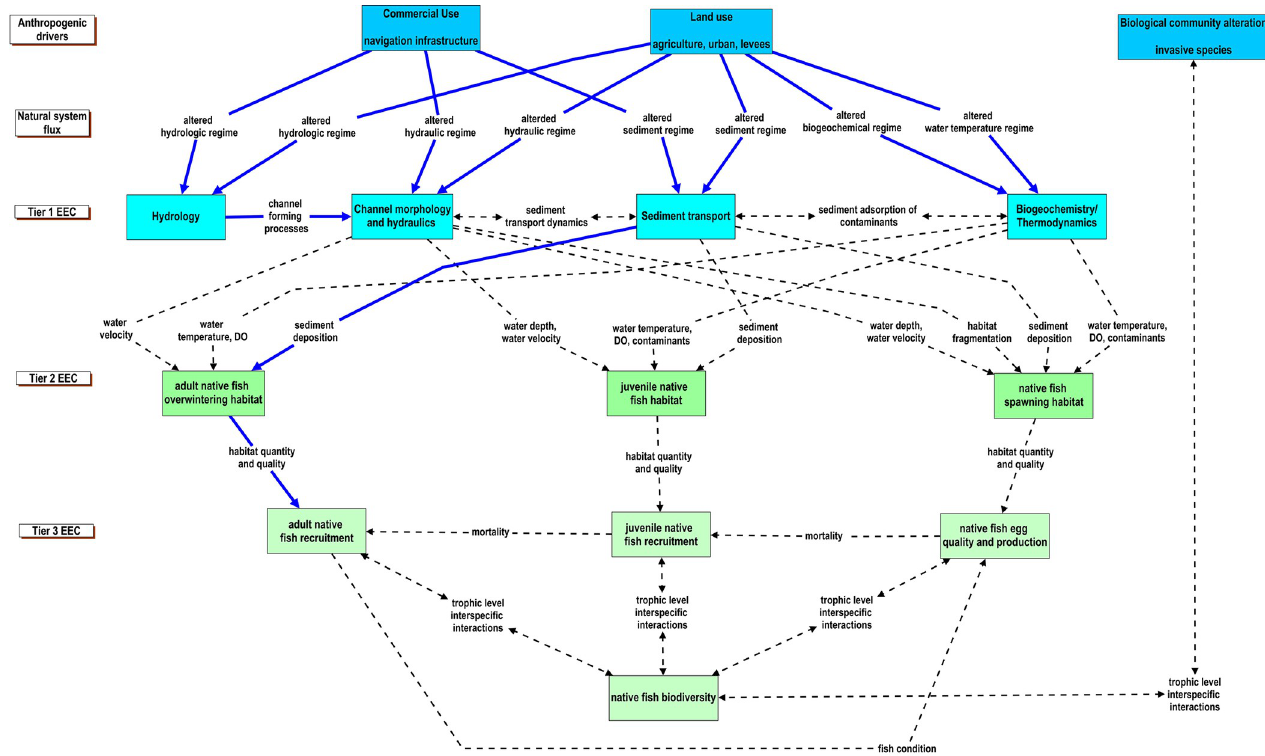
Fig 8. Conceptual model of how anthropogenic drivers in the upper Mississippi and Illinois Rivers influence native fish habitats and recruitment. Essential ecosystem characteristics (EECs) are groupings of ecosystem components. Tier 1 EECs represent physical and chemical effects; fundamental measures of process that are directly affected by anthropogenic and natural drivers. Tier 2 EECs represent a broad habitat category that is intended to encompass the physical, chemical, and biological components of the riverine habitats that influence reproduction, growth, and survival of biotic communities. The Tier 3 EECs represent components of the biological systems that respond to changes in the hierarchical components of the conceptual model. The strength of our understanding of the relationships of how natural and anthropogenic drivers interact with habitats, biological systems, and fish in large rivers is represented by the different types of lines in the figure. Solid blue lines depict a strong understanding of the relationship, the dotted-dashed blue line represents a moderate understanding of the relationship, and the black dashed line represents a weak understanding of the relationship. The different types of lines also represent the strength of our understanding of within EEC-tier